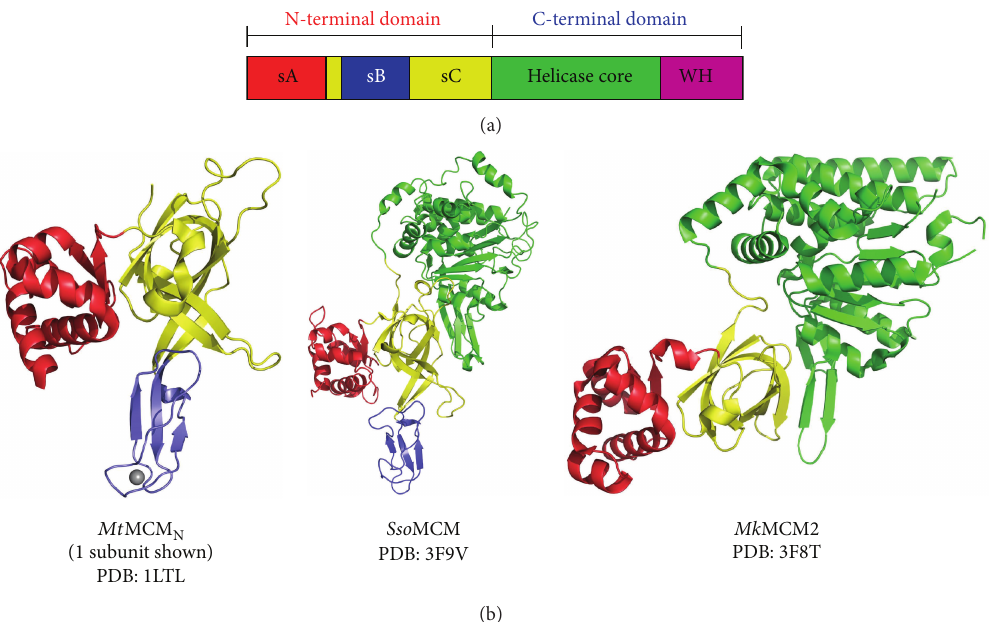
Figure2:GeneralarchitectureofMCMproteins.(a)MCMmonomerscanbesubdividedintoN-andC-terminaltiers.Eachtiercanbefurther subdivided, where the N-terminal half includes subdomains A (red), B (blue), and C (yellow) and the C-terminal domain contains the helicase core (green) and a winged helix domain (magenta). (b) The crystal structures of one subunit of the Methanobacterium thermoautotrophicum , PDB: 1LTL), monomeric Sulfolobus solfataricus MCM ( Sso MCM, PDB: 3F9V), MCM N-terminal domain double-hexamer ( 𝑀𝑡 MCM N and monomeric Methanopyrus kandleri MCM2 ( Mk MCM2, PDB: 3F8T) each illustrate the general architecture with distinct subdomains A, B, C, and a AAA+ ATPase domain. Subdomains A, B, and C consist of a helical bundle (red), a zinc-binding domain (blue), and an oligonucleotide/oligosaccharide- (OB-) binding fold (yellow), respectively. The AAA+ domain architecture has five 𝛽 -sheets flanked by 𝛼 - helices. All structure representations of Figure 2 were prepared with the Pymol software package